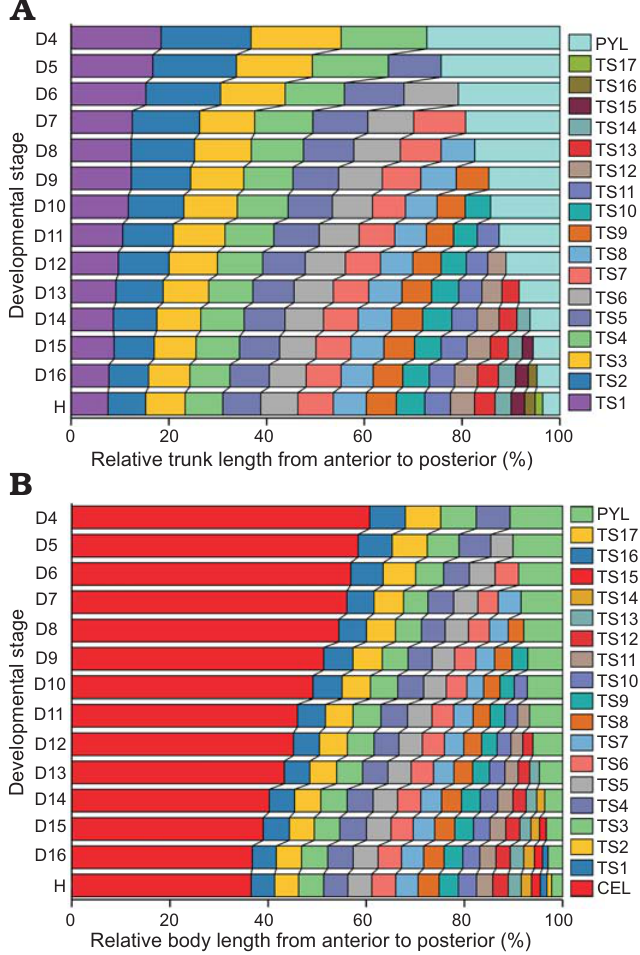
Fig. 9. Relative axial length of different body parts from the D4 to H stage of Changaspis elongata Lee in Chien, 1961. A . Relative trunk length of each thoracic segment and pygidium. B . Relative body length of cepha- lon, each thoracic segment and pygidium. Thorax and pygidium together constitute the trunk. Cephalon, thorax, and pygidium make up the body. Abbreviation: CEL, cephalic length; LTH, length of thorax; PYL, pygidial length; TS1, thoracic segment 1.